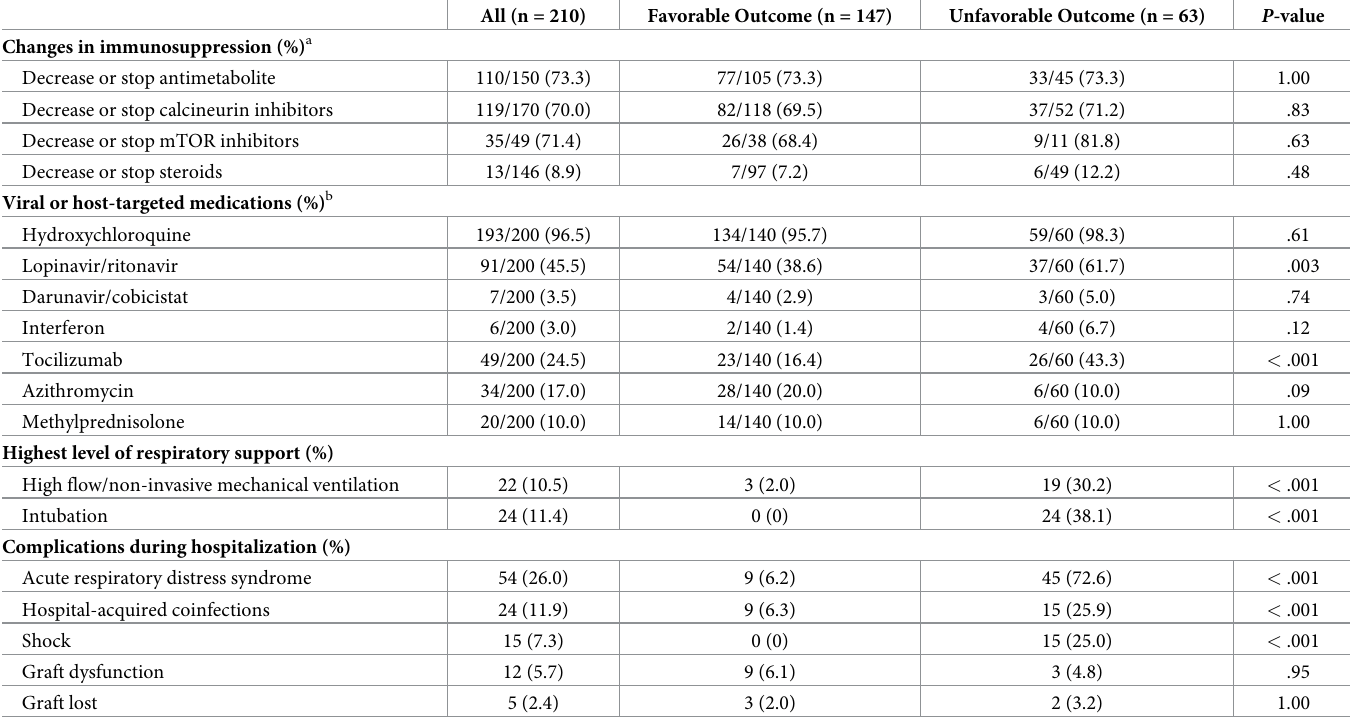
a Denominator includes patients on the agent at baseline and known adjustment status. b Denominator includes all patients under viral or host-targeted